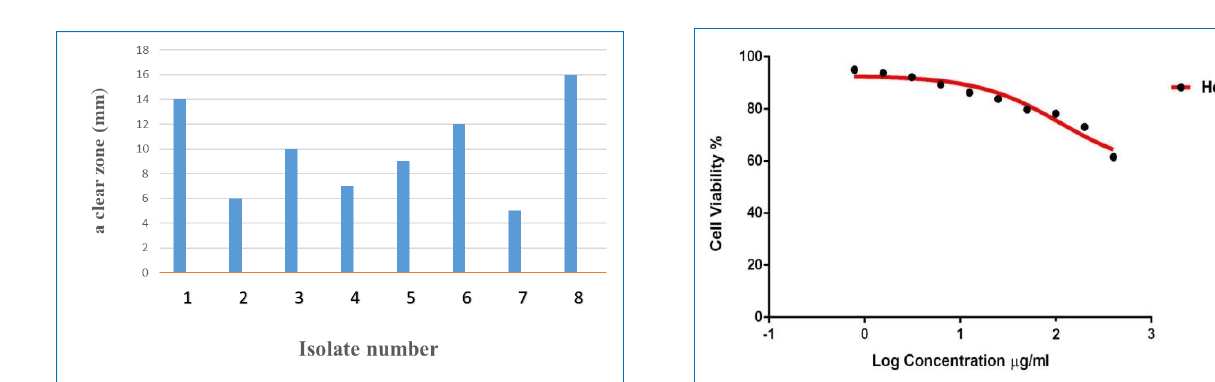
Figure, 1: Diameter of halo around colonies isolates on enzyme production medium.